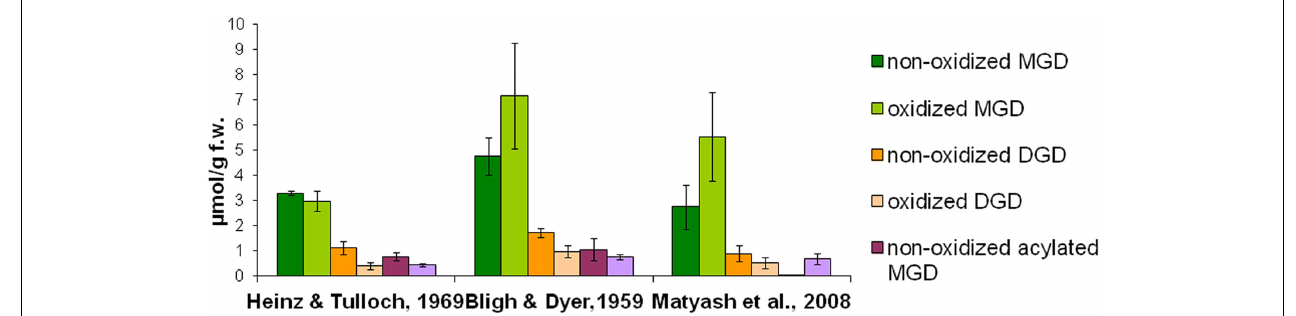
these extracts by using SPE and analyzed as well as quantified by HPLC/MS. The amounts of the respective species from the various galactolipid classes were summed.The mean values and SD of three parallel extractions are shown.